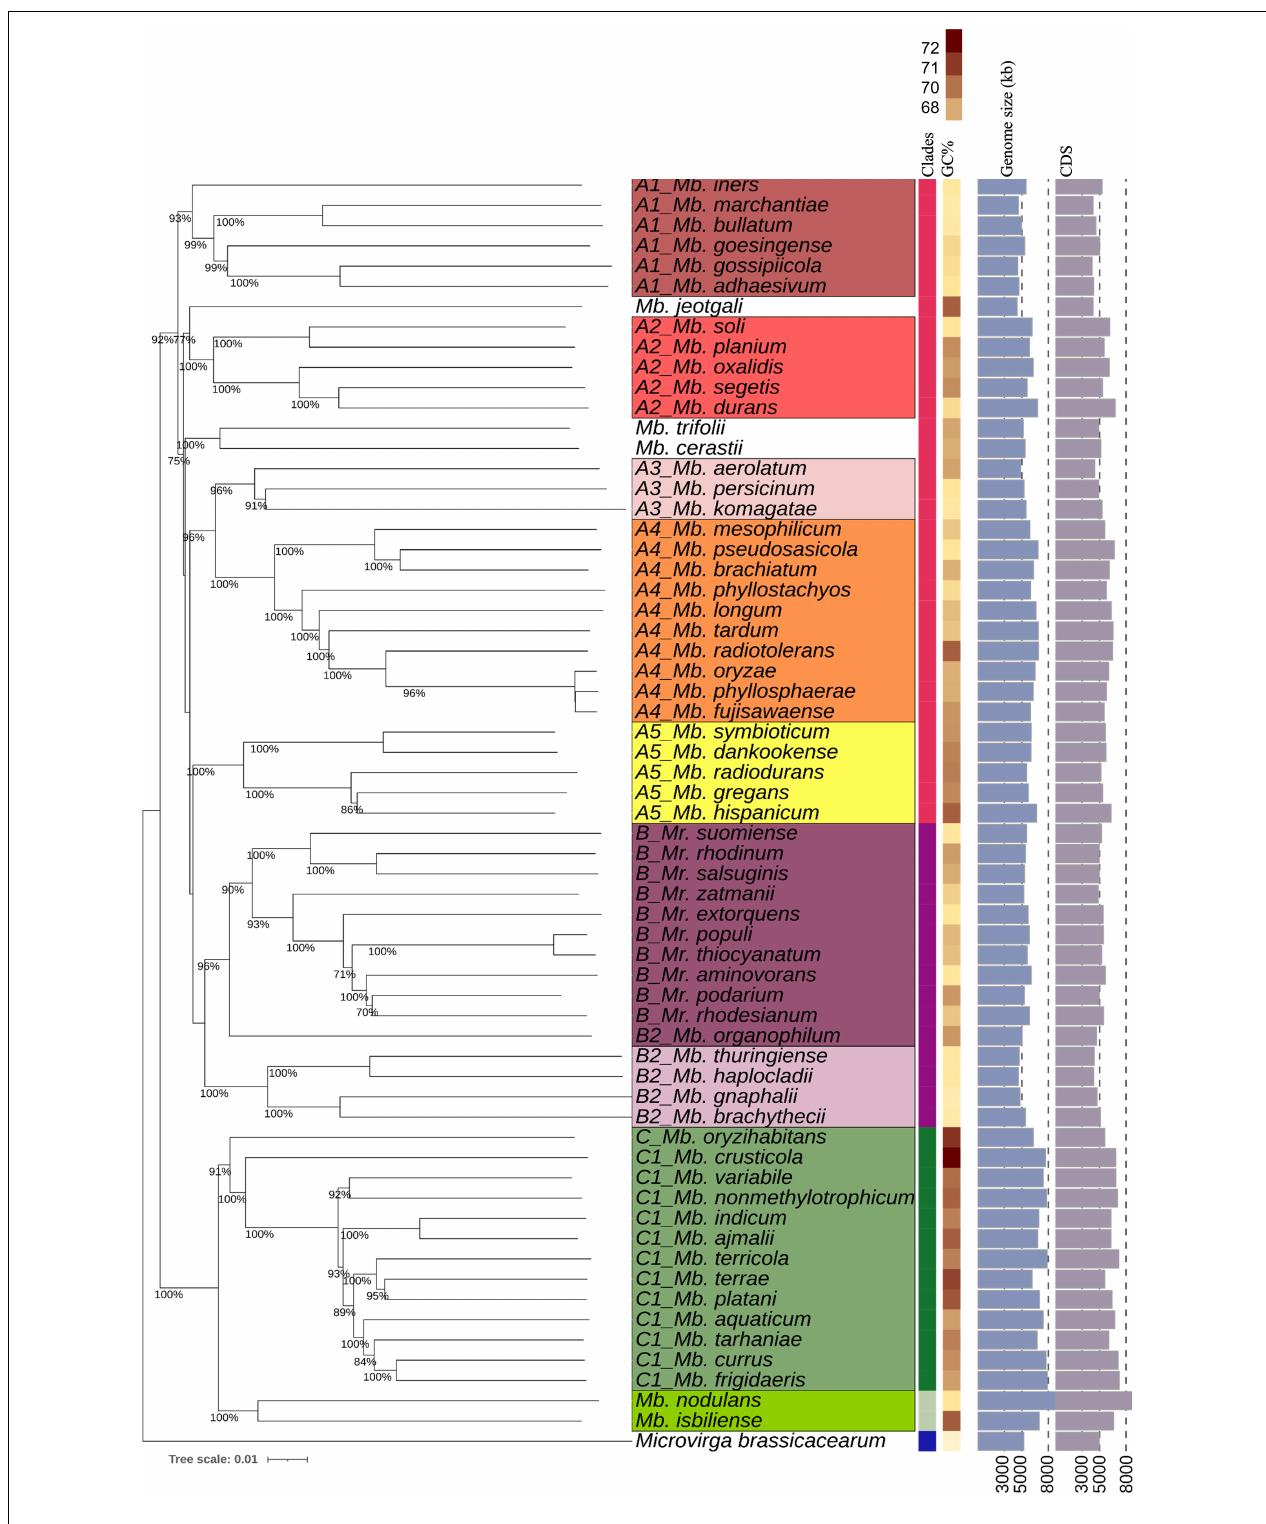
FIGURE 1 | TYGS-genome blast distance phylogeny (GBDP) of 62 PPFM type strains and an outgroup represented by Microvirga brassicacearum T . Colored column bars (left to right) indicate each strain’s clade, genome GC% content, genome size in kb, and number of coding sequences. Branch lengths are scaled based on GBDP formula d5 and numbers above the branch are bootstrap support values from 100 replications.